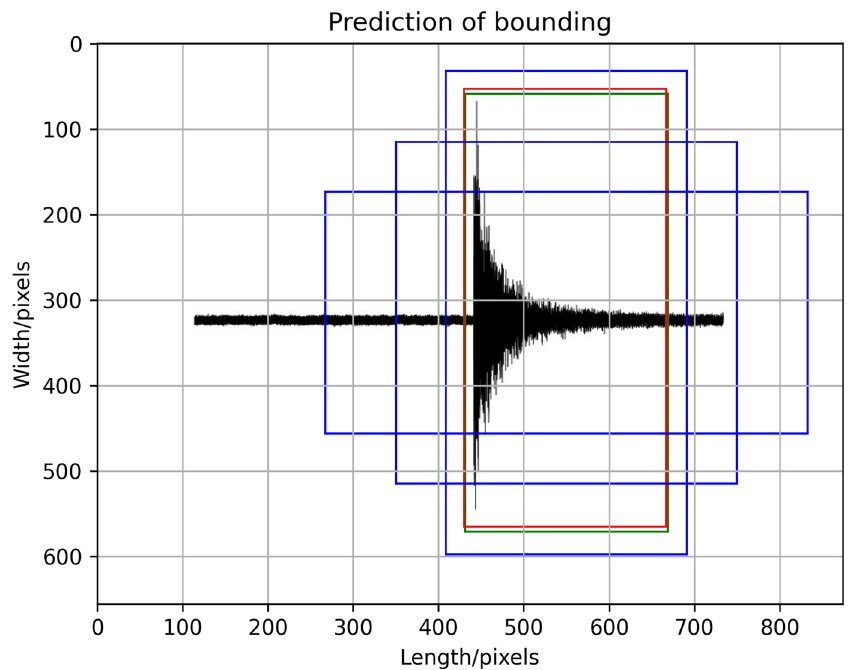
Figure 8. Prediction of bounding boxes. The blue box represents the set anchor box, the green box represents the ground-truth box, and the red box represents the predicted bounding box.